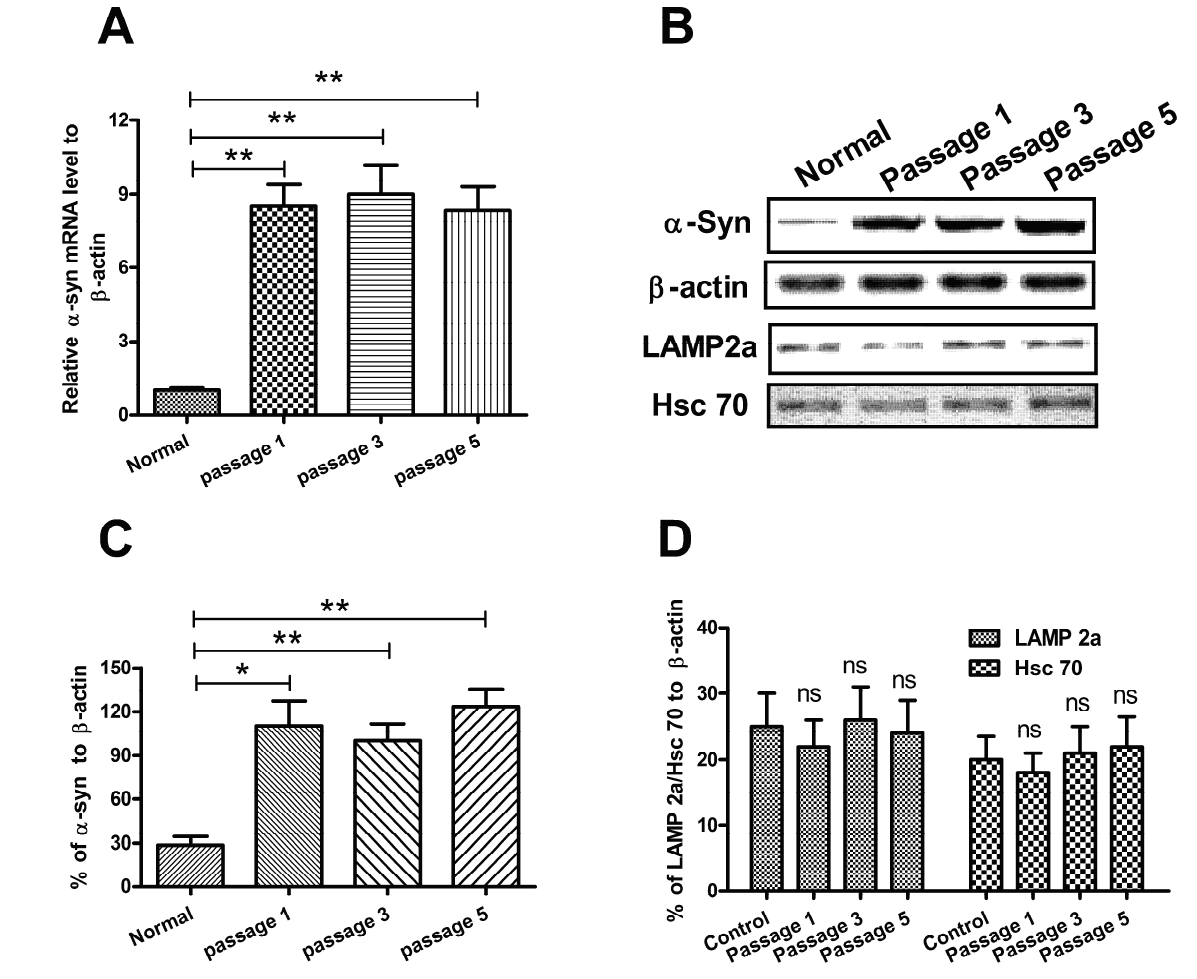
Figure 1. Over-expression of α -Syn in SH-SY5Ycell line. ( A ) Relative mRNA level of α -Syn in the SH-SY5Y-Syn(+) cells post various passages, compared to β -actin, revealed by quantitative real-time RT-PCR; ( B ) Western blot analysis of α -Syn, LAMP2A and Hsc 70 in the SH-SY5Y-Syn(+) cells, post various passages; ( C ) Significantly high level of α -Syn in variously propagated SH-SY5Y-Syn(+) cells; ( D ) LAMP2A and Hsc 70 protein level in the SH-SY5Y-Syn(+) cells, post various passages. Data represent the mean ± SEM of three independent experiments. Statistical significance was considered with